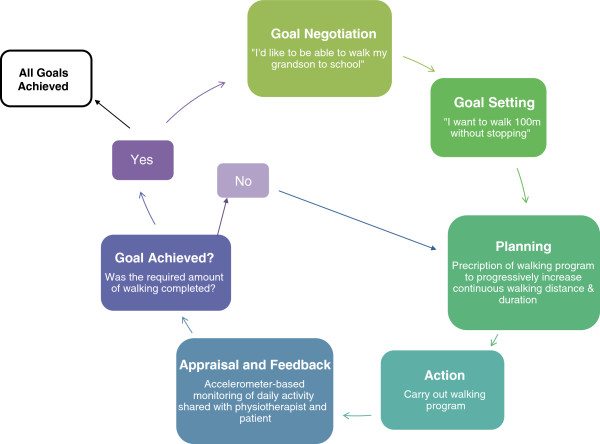
Model showing the goal-setting and goal-planning process (modified from Scobbie et al., 2010; [[27]]. The patient may identify a broad walking goal upon admission to rehabilitation, such as “I want to be able to walk better”. The physiotherapist would discuss this goal with the patient and determine a more measurable and meaningful goal, such as “I want to be able to walk my grandson to school, which is 300m away from my house”. A short-term sub-goal is then established to help the patient progressively achieve their longer-term goal; i.e. “I want to walk 100m without stopping”. Following identification of short-term goals, a rehabilitation plan is developed and put into action. Progress towards the goal is appraised and feedback is provided to the patient; it is at this point in the goal-setting process that accelerometers can be beneficial. The appraisal will allow therapists and patients to determine if the sub-goal has been achieved. If so, a more challenging sub-goal may be developed. If the sub-goal was not achieved, the physiotherapist may modify his/her treatment plan. This cycle continues until all goals are achieved.